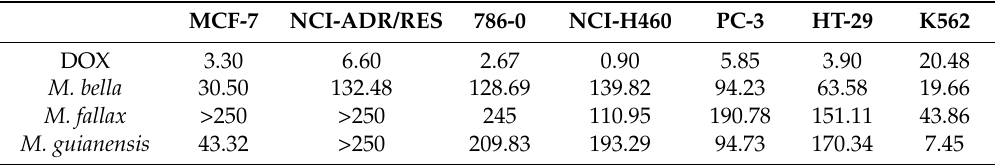
Table 4. Total Growth Inhibition (TGI) values, given in µ g · mL − 1 , for Myrcia spp. extracts and doxorubicin (DOX) necessary for total inhibition of tumor cell